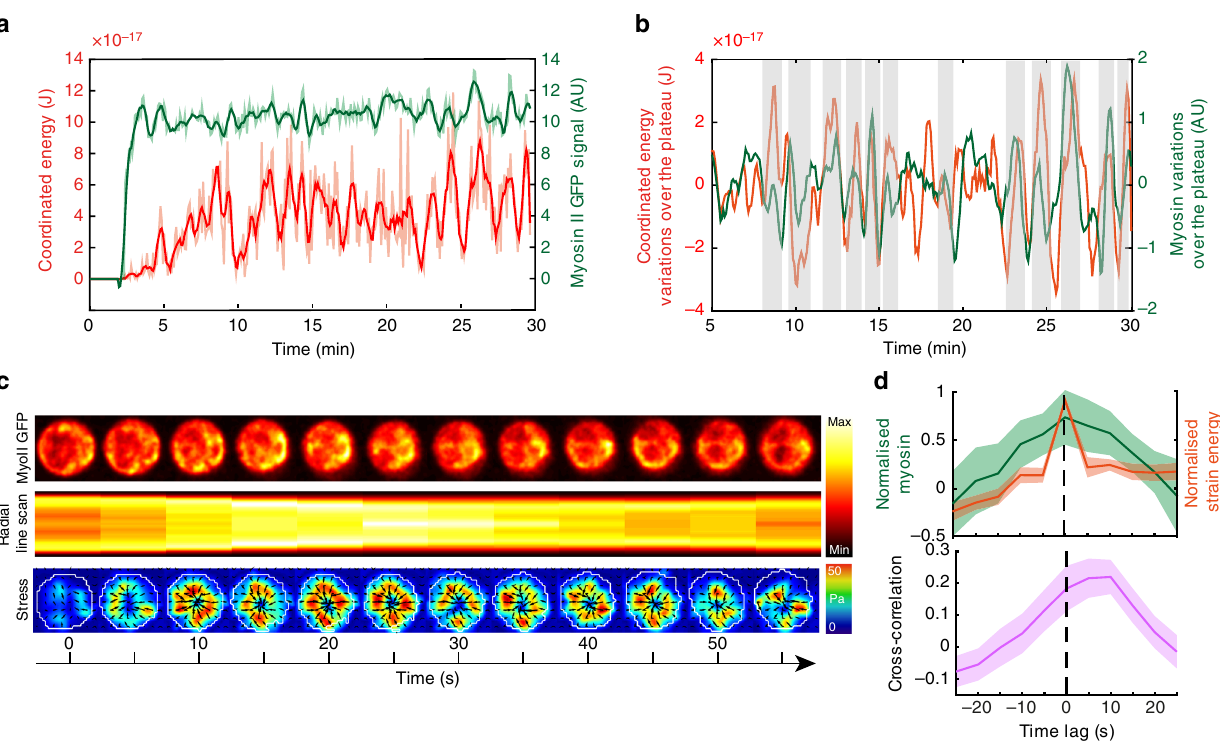
Fig. 3 Myosin II recruitment is associated to global contractions. a Example of strain energy and myosin II GFP signal at the synapse. b The two signals (once de-trended) show concomitant peaks. c Time-lapse images showing dynamics of myosin II GFP, radial linescan (presented as a kymograph, time in x axis) and corresponding stress map: a contraction peak is visible at times t = 20 – 30 s. d Average of different peaks and cross-correlation between strain energy and myosin II peak intensity: myosin peak precedes the energy peak of ~ 5 – 10 s (Mean ± SEM, n = 40 peaks, from 15 cells, four independent experiments). Source data are provided as a Source Data fi